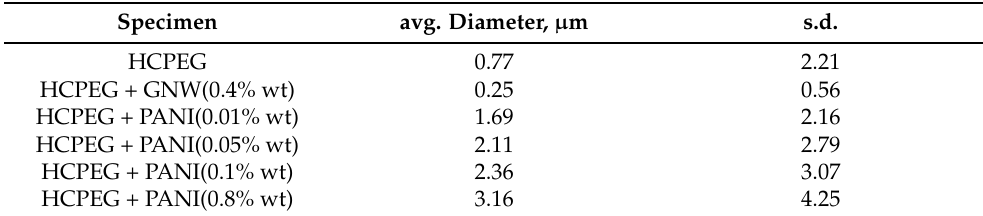
Table 1. Average pores sizes and standard deviations of the several materials (avg. stands for average, s.d. for standard